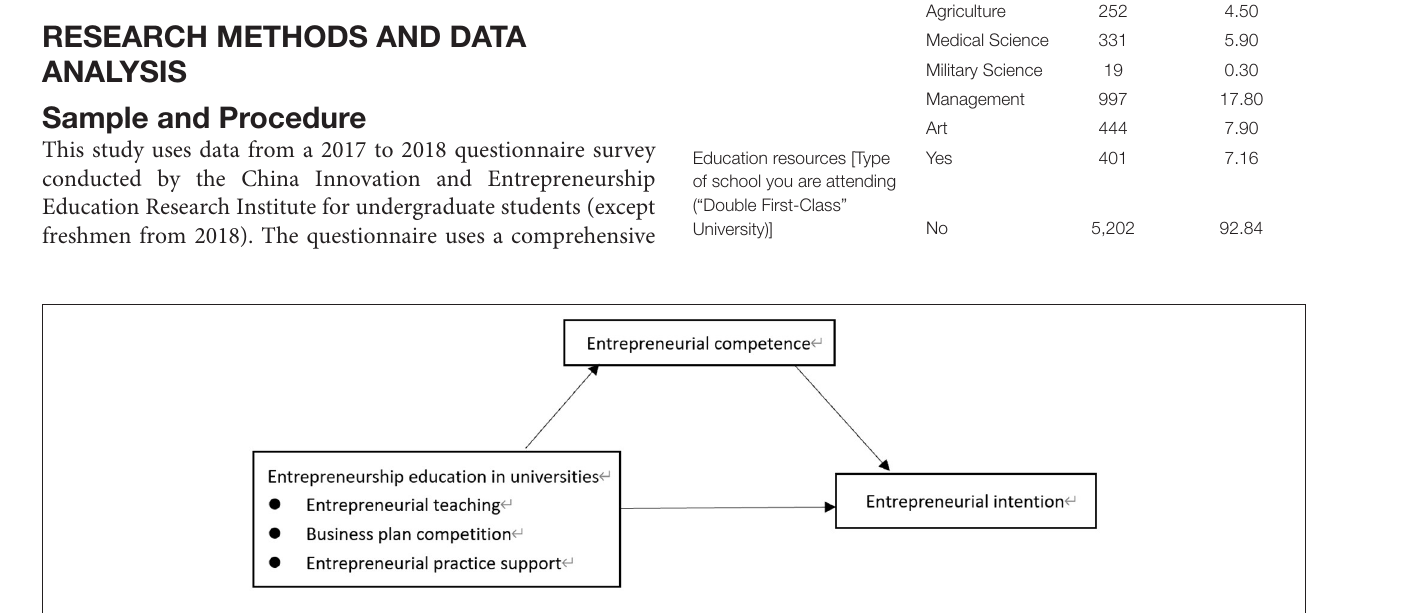
FIGURE 1 | Theoretical